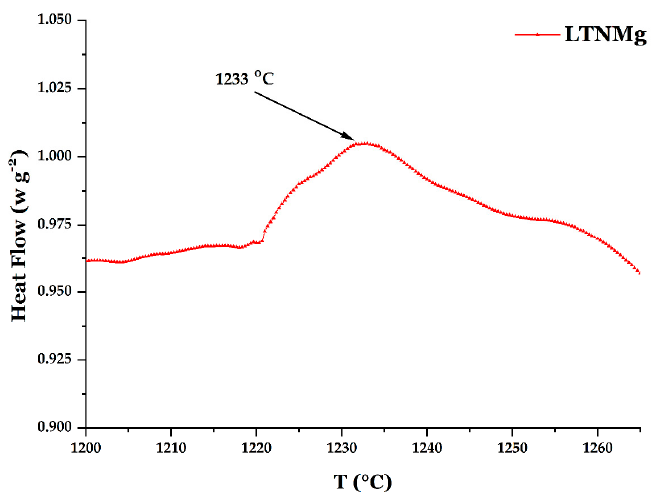
Figure 2. Differential scanning calorimetry (DSC) profile of Li 0.95 Ta 0.76 Nb 0.19 Mg 0.15 O 3 .